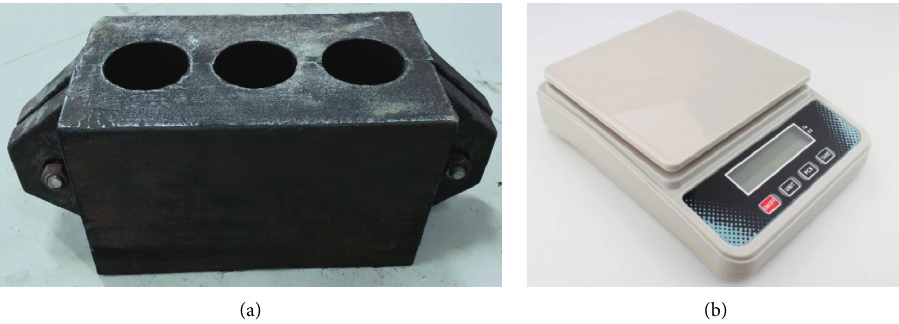
Figure 2: Tools. (a) Sample filling mold. (b) An electronic scale.